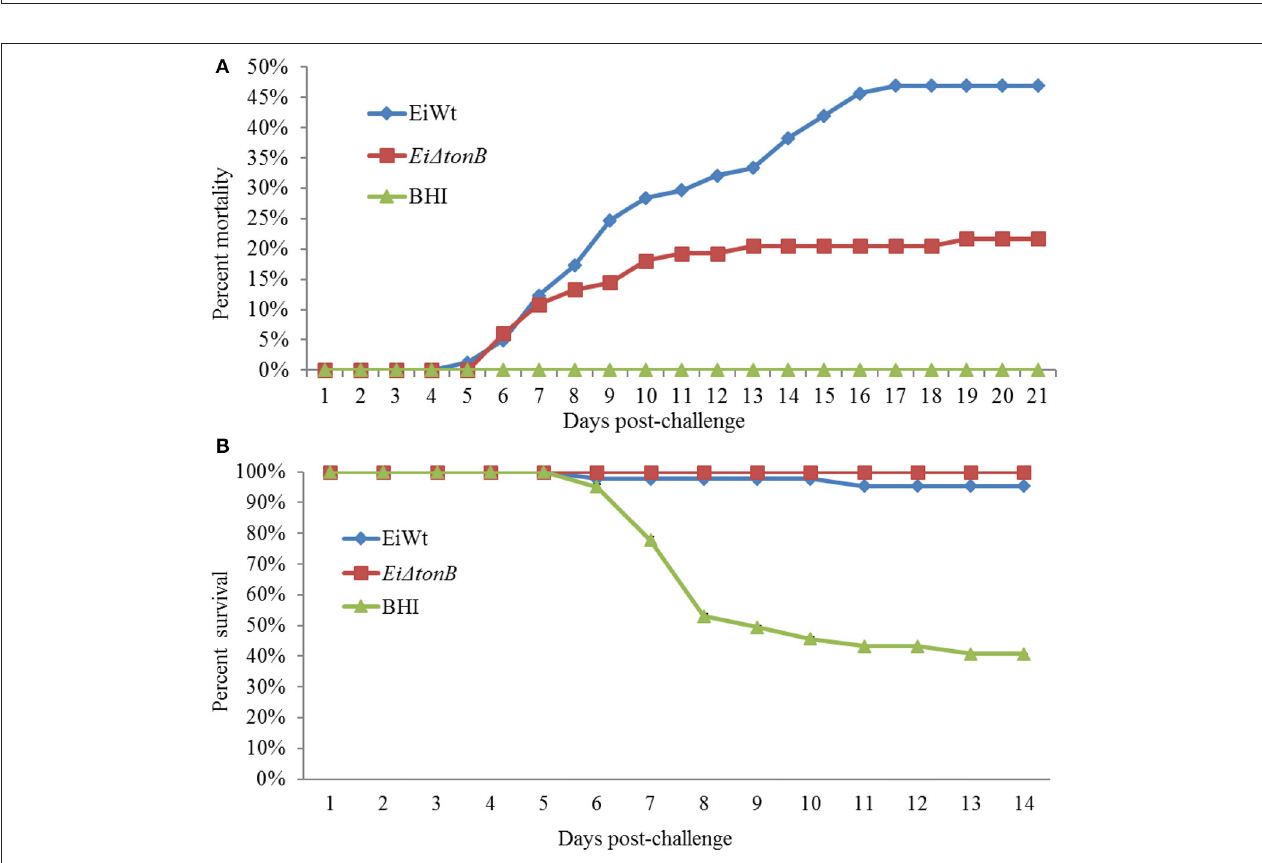
FIGURE 5 | Mean percent mortalities resulting from immersion challenge of Ei 1 tonB and 93–146 in channel catfish fingerlings (A) . Mean percent survival of catfish fingerlings surviving infection with Ei 1 tonB and re-challenged with 93–146 at 21days post-immunization (B) .